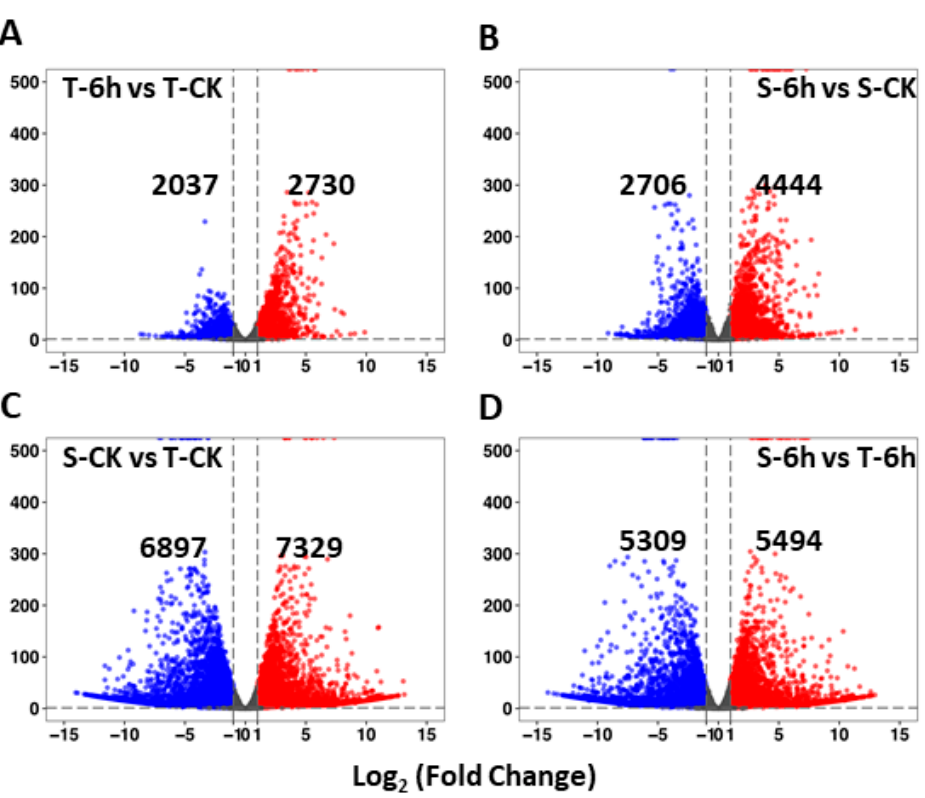
Figure 2. Volcano plots showing the differentially expressed genes (DEGs) between different materials and treatments. ( A , B ) DEGs between materials responding to flooding; ( C , D ) DEGs between treatments of different materials. CK, control; T, tolerant; S, sensitive.